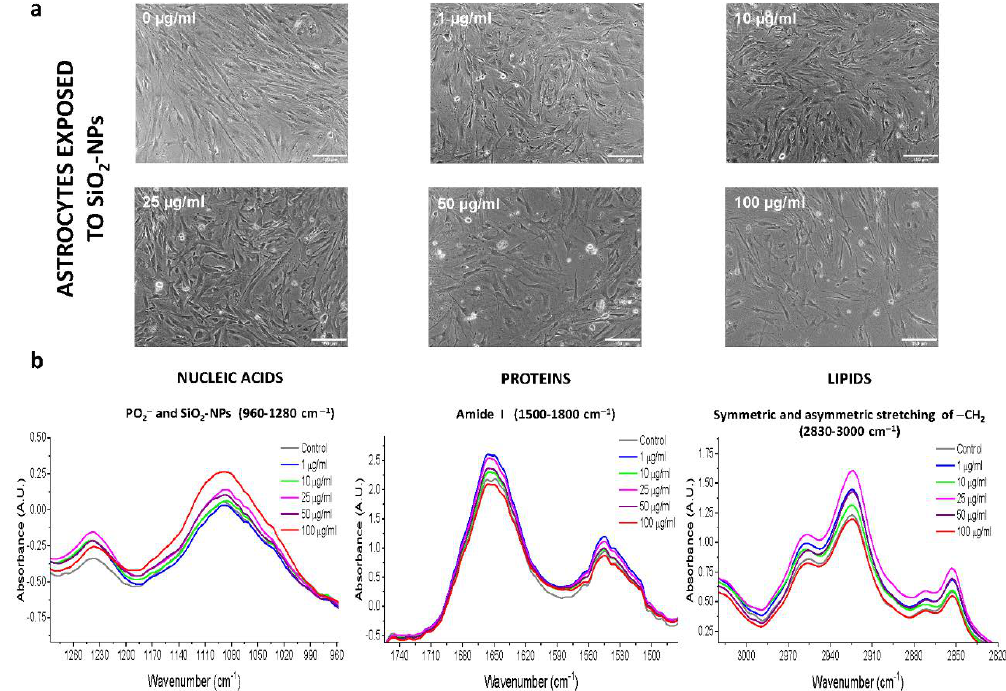
Figure 2. Morphological changes and normalized IR spectra of primary cultures of astrocytes exposed to SiO 2 -NPs. ( a ) Astrocyte morphology after 24 h of SiO 2 -NPs exposure. Images were obtained by light microscopy. Each treatment was performed at least in triplicate ( n = 3) with three technical replicates. Subtle morphological changes compared to control culture are appreciated at 1, 10, and 25 µg/mL SiO 2 -NPs. At 50 µg/mL and 100 µg/mL SiO 2 -NPs, the size and amount of the astrocytes decreased markedly in comparison with the control. Scale bar: 150 µm. ( b ) Normalized IR spectra of astrocytes exposed to SiO 2 -NPs. The spectral region of 960–1280 cm −1 corresponds to PO 2 - (nucleic acids) and SiO 2 -NPs; 1500–1800 cm −1 is the spectral region that contains the amide I spectral bands and representative bands of the secondary protein structure; 2830–3000 cm −1 includes the spectral bands of symmetric lipid CH 2 and asymmetric CH 2 . The spectral images are representative of four independent experiments performed with each treatment, with three technical replicates.